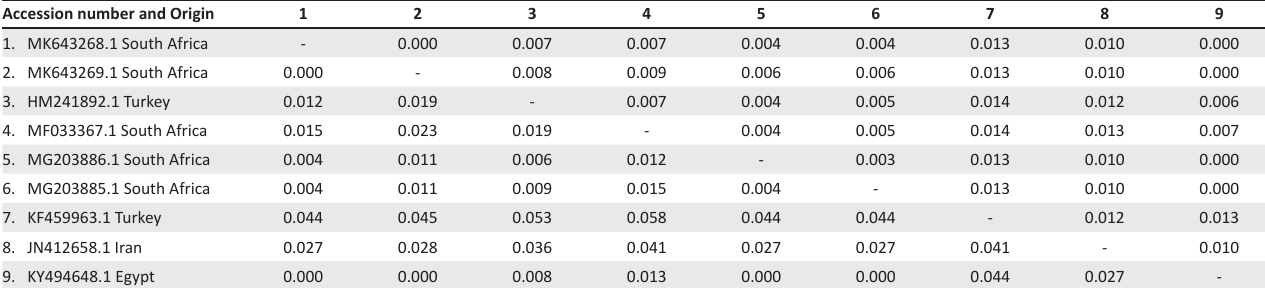
FIGURE 3: In phylogenetic tree analysis of Theileria ovis based on 18S ribosomal ribonucleic acid gene, the tree was constructed with maximum likelihood method based on Jukes–Cantor model, with bootstrap values (expressed as percentages of 1000 replications) superimposed at branching points. The sequences produced in this study are shown with bullet points. The evolutionary distances were computed using the p -distance method. Theileria luwenshuni was used as an TABLE 5: Evolutionary divergence of Theileria ovis representing 439 base pair region and expressed as pairwise distance ( p -distance) (bottom left) and standard error (top right). Accession number and Origin